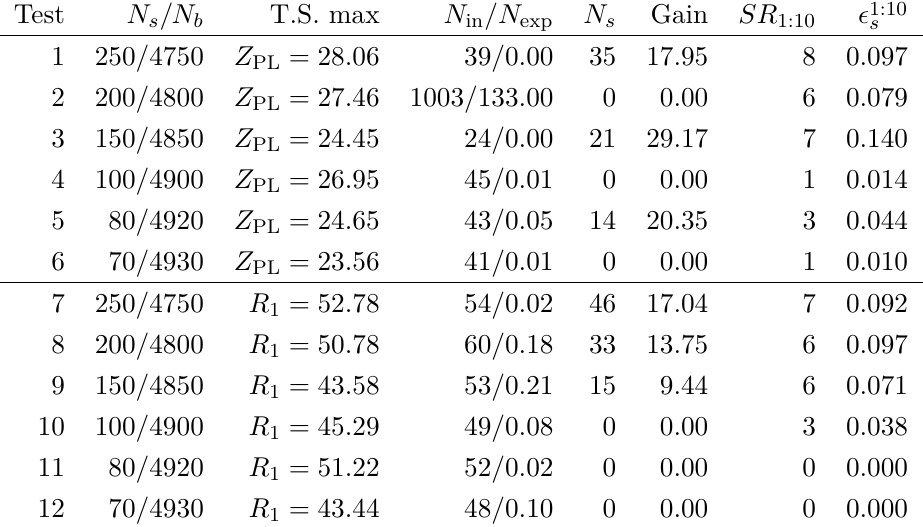
Table 6 . Sample results of RanBox runs on 5000 events from the HEPMASS dataset, with varying signal fraction and the two choices of test statistic. See the text for more